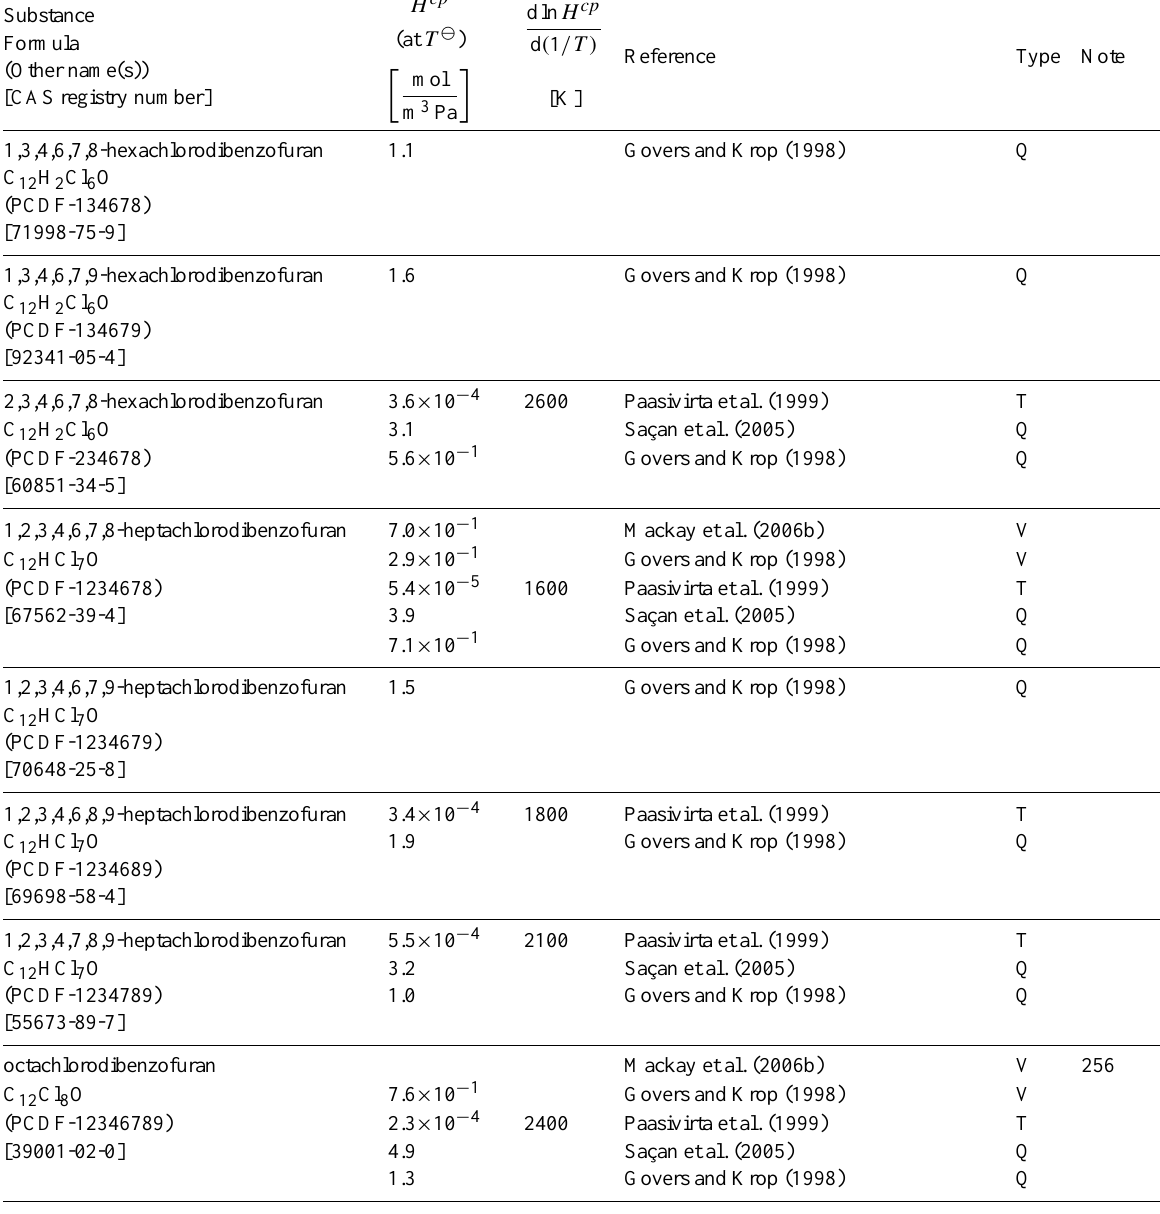
Table 6: Henry’s law constants for water as solvent